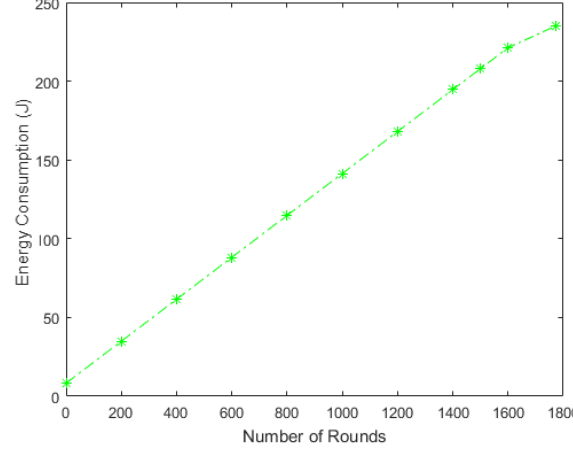
Figure 5. Total network energy usage.